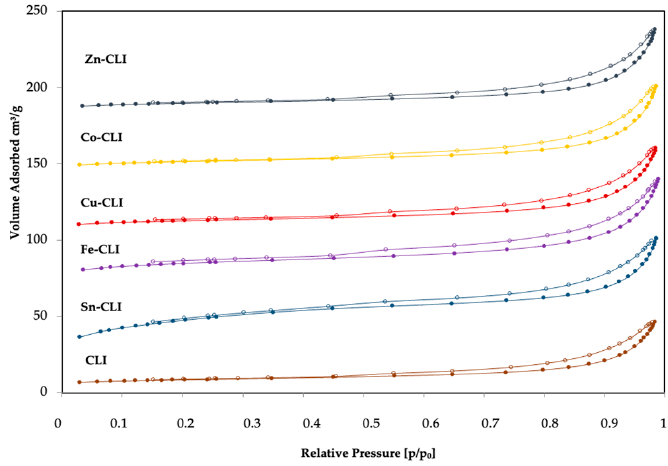
Figure 5. Nitrogen adsorption and desorption isotherms for natural clinoptilolite zeolites.